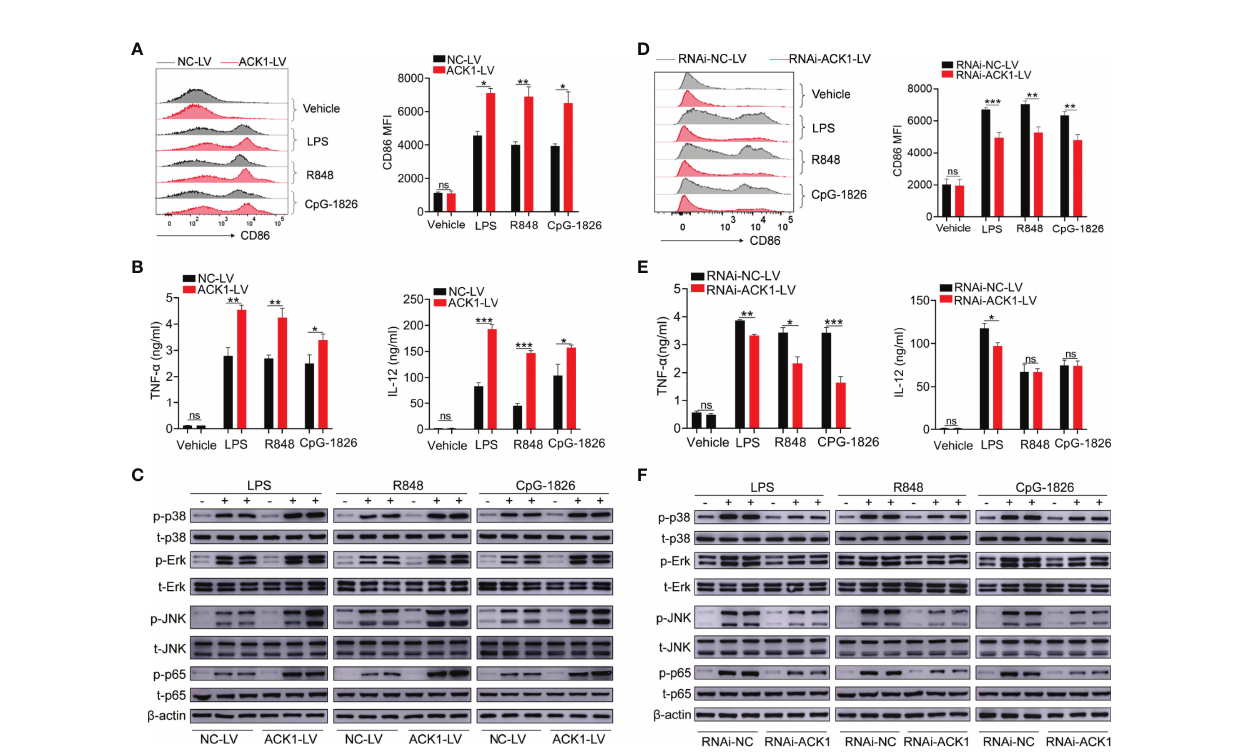
FIGURE 2 | ACK1 augments the activation of BMDMs induced by TLRs. (A – C) BMDMs were infected with lentivirus that highly expresses ACK1 (ACK1-LV) or negative control lentivirus (NC-LV) for 3 days followed by stimulation of LPS (100 ng/mL), R848 (1 m g/mL) and CpG-1826 (1 m M). The expression of CD86 (A) on BMDMs was detected by fl ow cytometry at 24 hours. The levels of TNF- a and IL-12 in culture supernatant were detected by ELISA at 24 hours (B) . The phosphorylation levels of p38, Erk, JNK and p65 were analyzed by western blot at 1 hour (C) . (D – F) BMDMs were infected with lentivirus that knockdown ACK1 expression (RNAi-ACK1-LV) or negative control lentivirus (RNAi-NC-LV) for 3 days followed by stimulation of LPS (100 ng/mL), R848 (1 m g/mL) and CpG-1826 (1 m M). The expression of CD86 (D) on BMDMs was detected by fl ow cytometry at 24 hours. The levels of TNF- a and IL-12 in culture supernatant were detected by ELISA at 24 hours (E) . The phosphorylation levels of p38, Erk, JNK and p65 were analyzed by western blot at 1 hour (F) . The data shown represent the means of three independent experiments and the error bars represent the S.E.M. * p < 0.05, ** p < 0.01, and *** p < 0.001, as determined by ANOVA tests; ns denotes p >